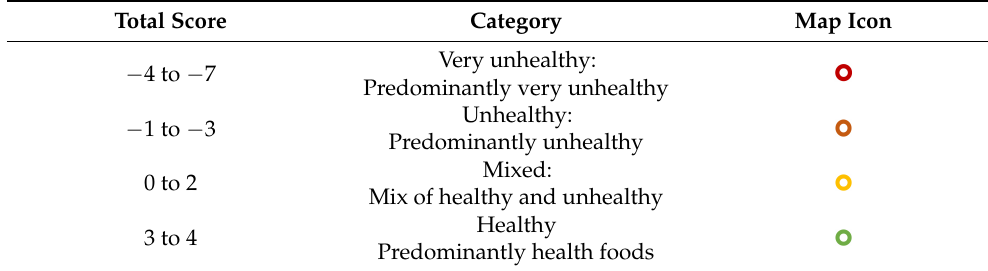
Table 3. Total healthfulness score categorization.